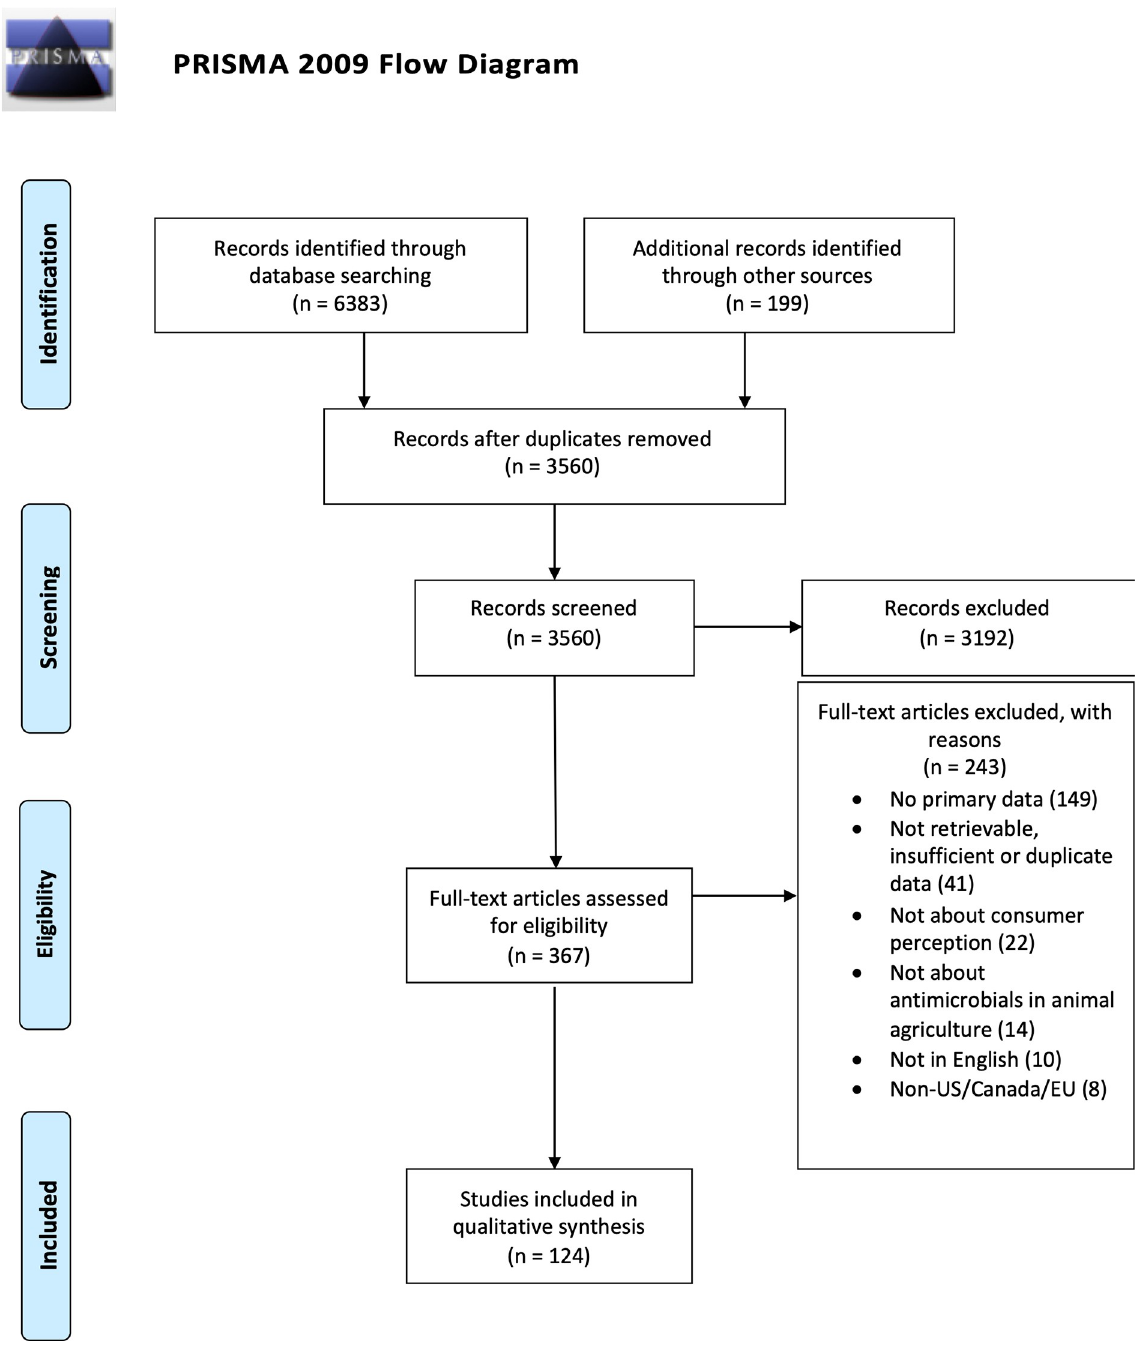
Fig 1. PRISMA flow chart. Number of sources found at each stage of retrieval, screening, and data extraction.